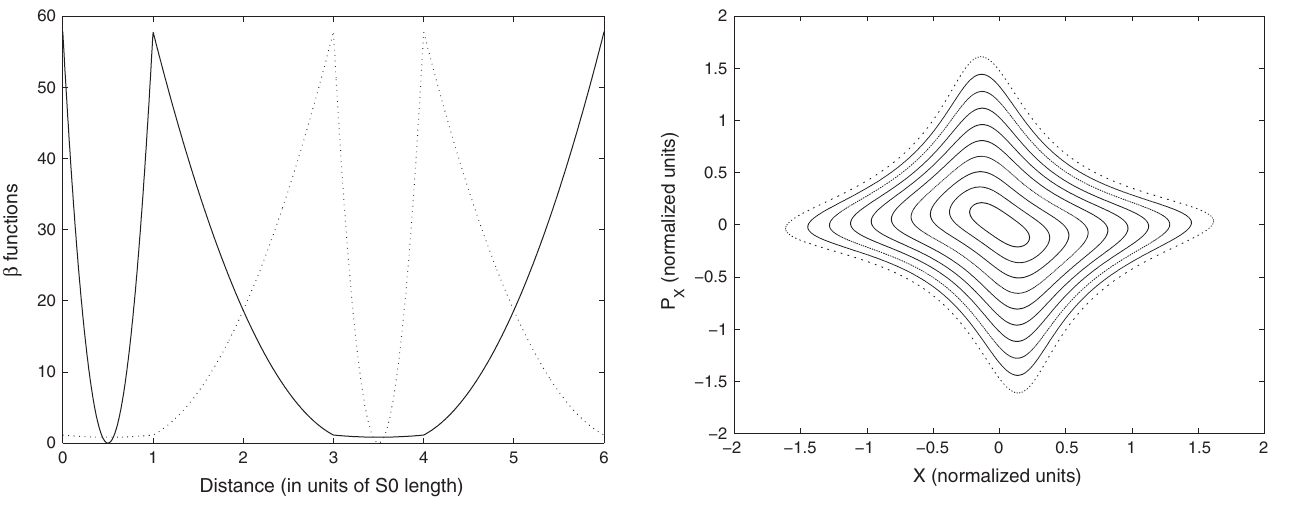
FIG. 2. Horizontal (solid) and vertical (dashed line) beta func- tions for p ¼ 2